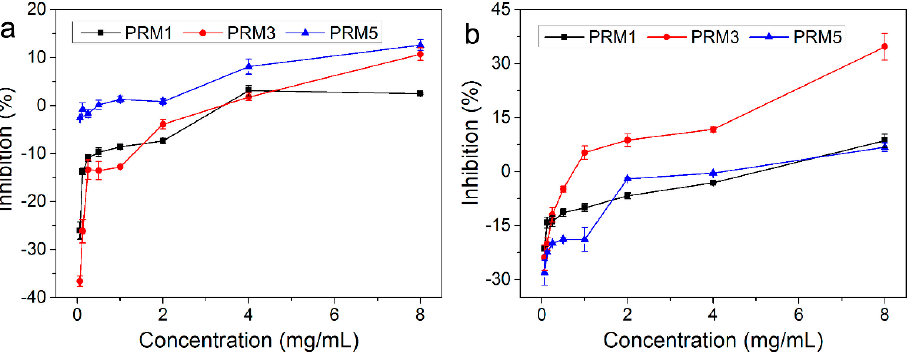
Figure 5. In vitro anticancer activities of PRM1, PRM3 and PRM5 against human breast cancer MCF-7 cells determined by MTT method. ( a ) Treatment for 24 h; ( b ) Treatment for 48 h.